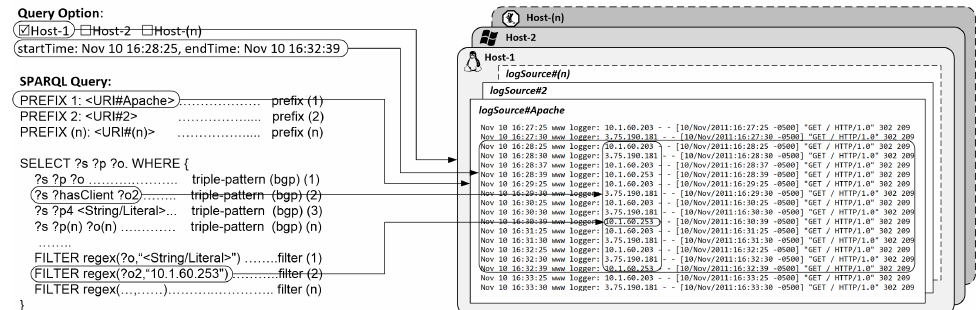
Figure 5. SPARQL Query translation